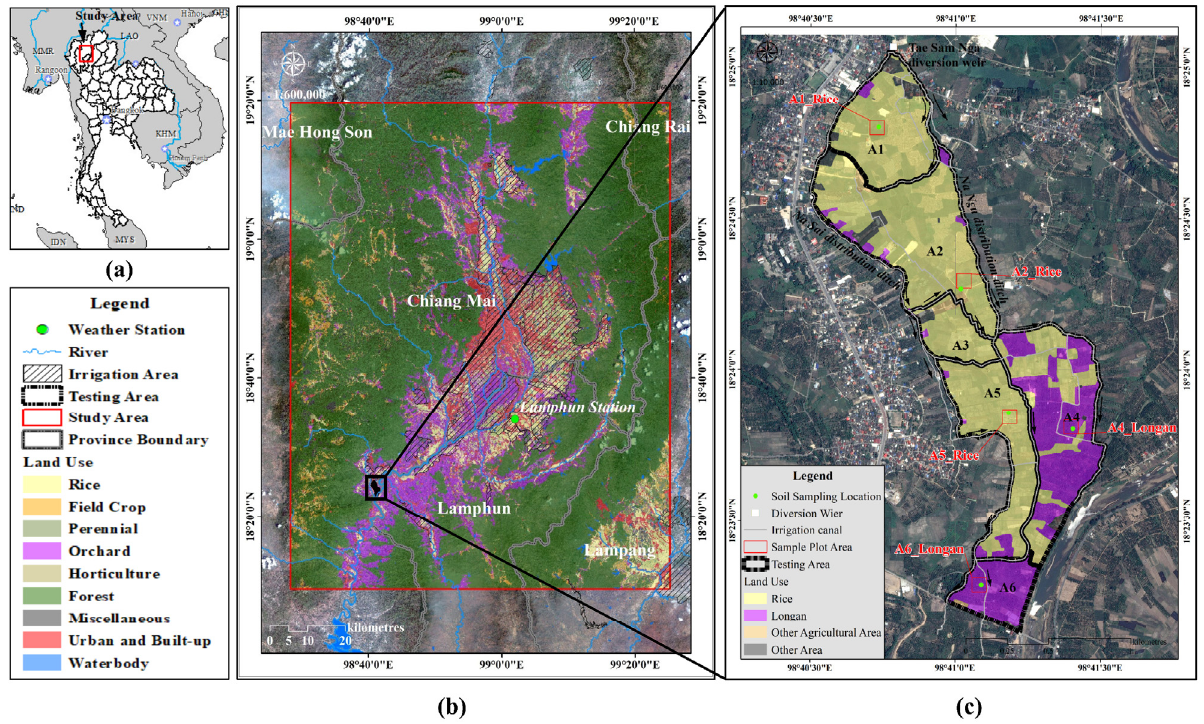
Figure 1. Study and testing areas: ( a ) general location of the study area in Thailand; ( b ) location of the study areas in the Chiang Mai and Lamphun provinces, which are situated in the plains of the upper northern region of Thailand along the Ping River; ( c ) testing area, which forms part of the Muang Luang Irrigation Project located in the Chom Thong District, Chiang Mai Province, downstream of the Muang Luang